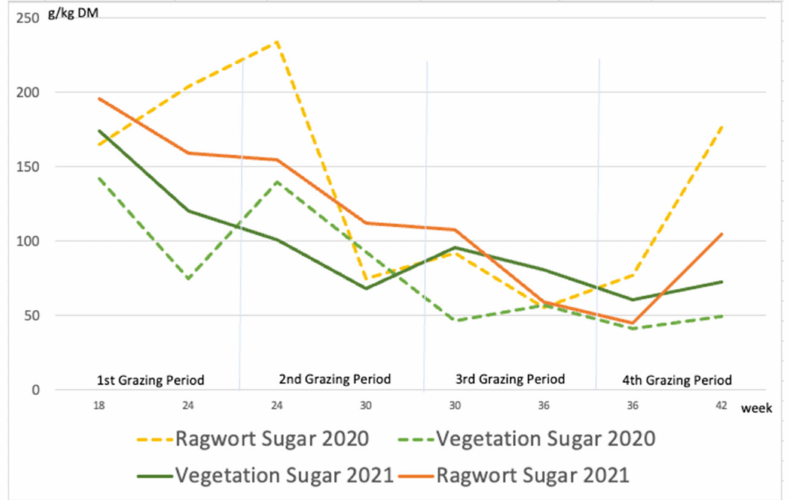
Figure 3. Content of sugar (g/kg DM) in ragwort and other plants (“vegetation”) over the course of the four grazing periods in 2020 and 2021.